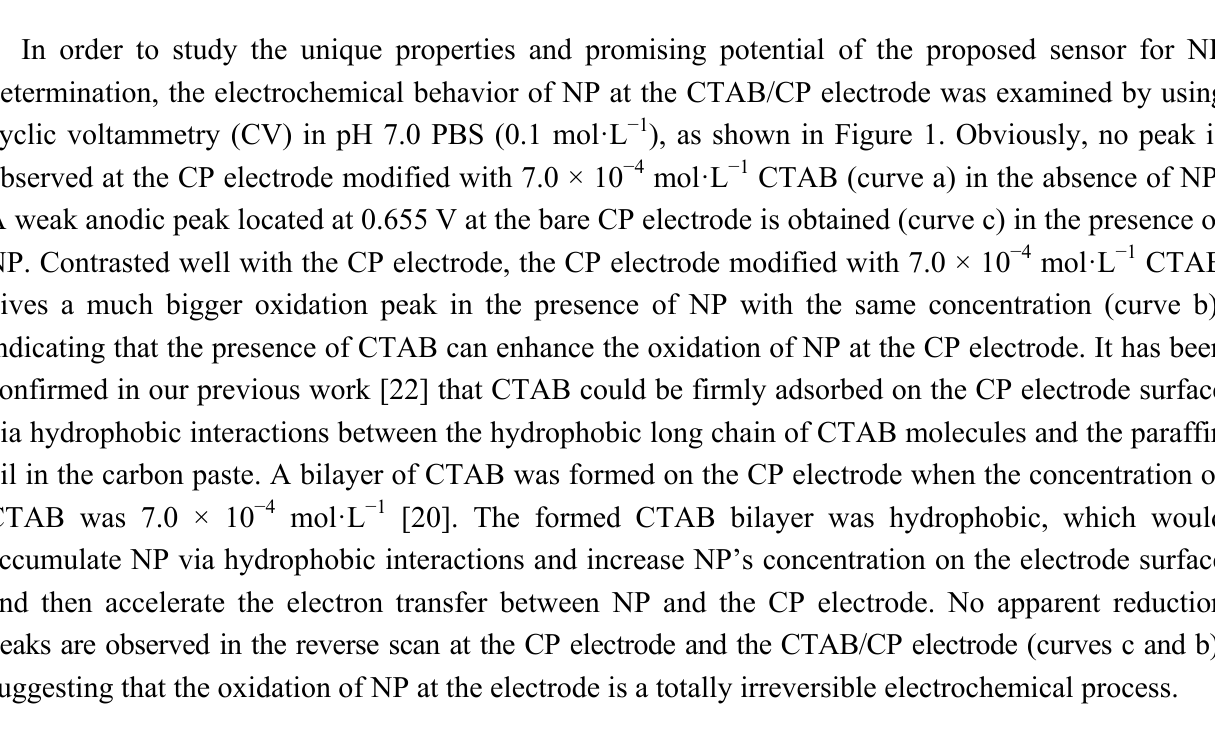
Figure 1. Cyclic voltammograms at 100 mV/s in 0.1 M PBS (pH 7.0) for the CTAB/CP electrode (a) in the absence of NP and (b) in the presence of 20 μ M NP, and (c) the bare CP electrode in the presence of 20 μ M